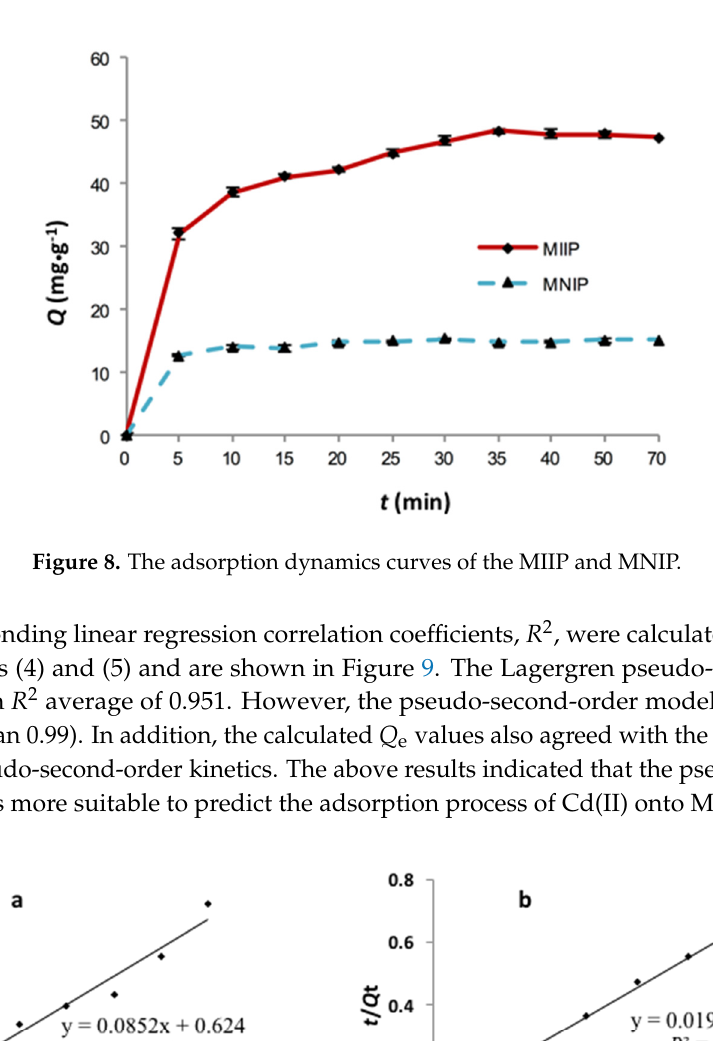
8 of 13 Figure 7. The fitting curves of Freundlich (a) and Langmuir (b) adsorption isotherm of MIIP. 3.2.2. Adsorption Kinetics The effect of contact time on the adsorption capacity of Cd(II) ion on the MIIP in aqueous